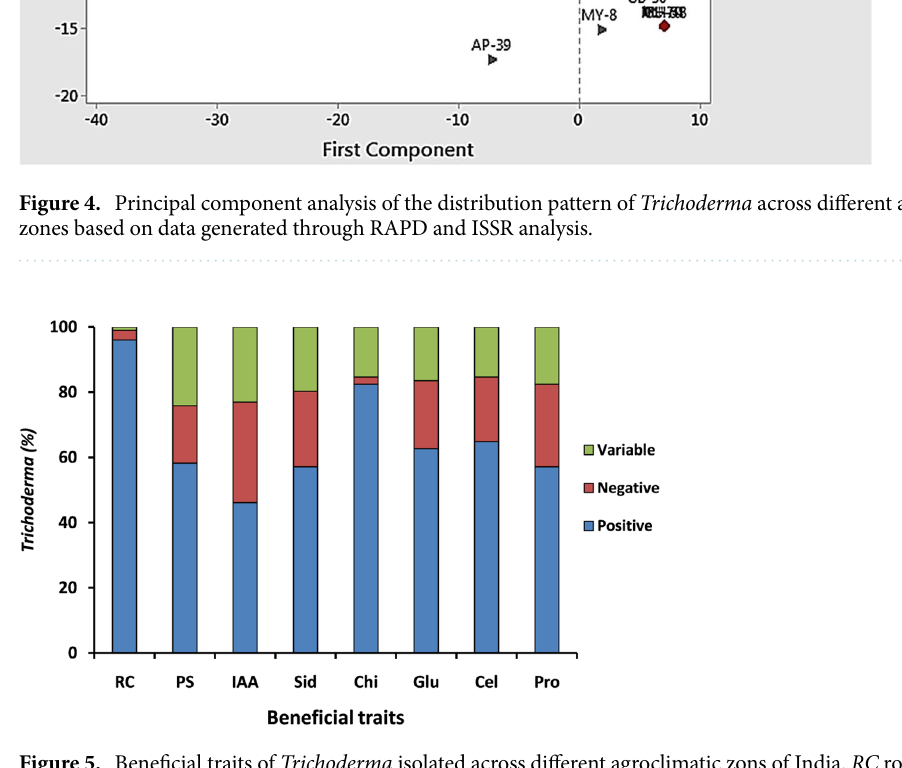
Figure 5. Beneficial traits of Trichoderma isolated across different agroclimatic zons of India. RC root colonization, PS phosphate solubilization, IAA indole acetic acid production, sid siderophore production, Chi chitinase, Cel cellulase, Pro protease